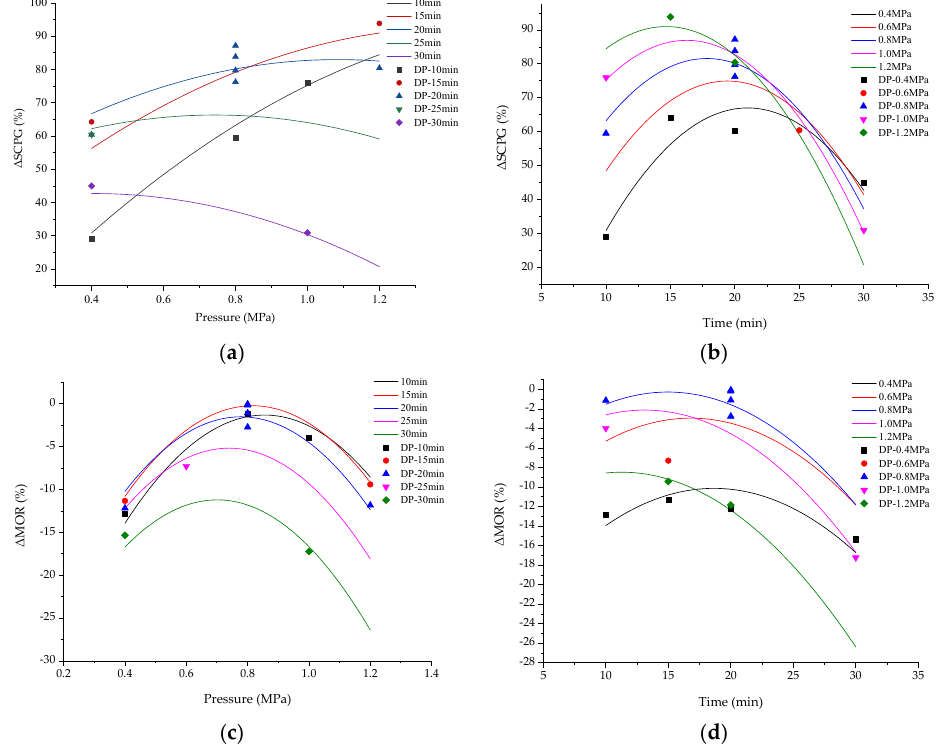
Figure 6. Effect of variables on Δ SCPG and Δ MOR : ( a ) effect of pressure on Δ SCPG ; ( b ) effect of time on Δ SCPG ; ( c ) effect of pressure on Δ MOR ; ( d ) effect of time on Δ MOR . Note: The mark of “DP” in the legend indicates the design point in the RSE.